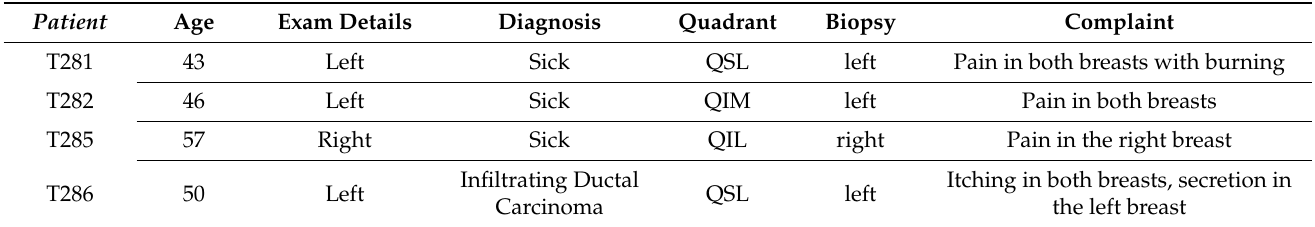
Figure 1. Raw static images of patients #T281 and #T282. Table 1. Relevant medical information. QSL = Upper Side Quadrant, QIL = Lower Side Quadrant. QIM = Upper Middle Quadrant, None of the patients had mammography.